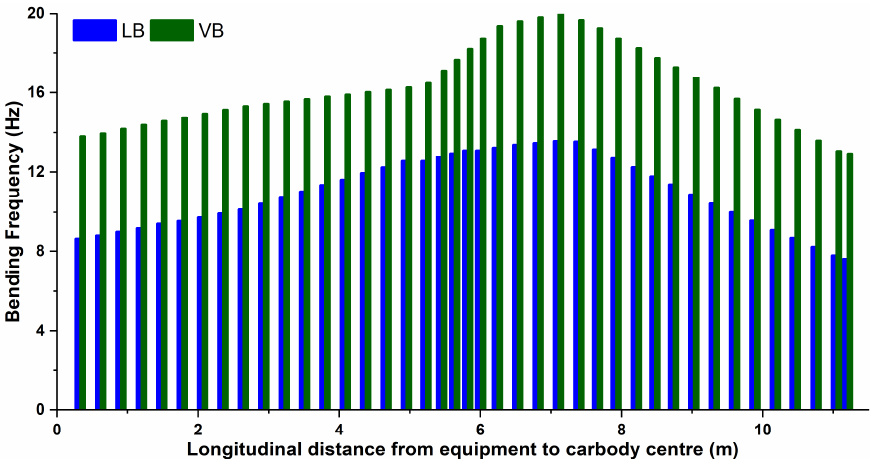
Figure 8. Association of LBF and VBF with the longitudinal distance from equipment to CB center for rigid suspended equipment.